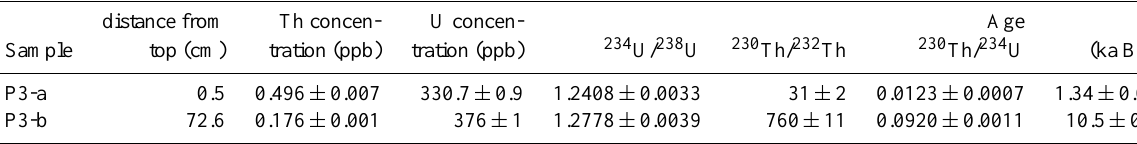
Table 1. Results of 230 Th-dating of stalagmite P3 (see Fleitmann et al., 2007 for details on the analytical techniques). * For dating of stalagmites D1 and Y99, see Fleitmann et al. (2007, 2011b).